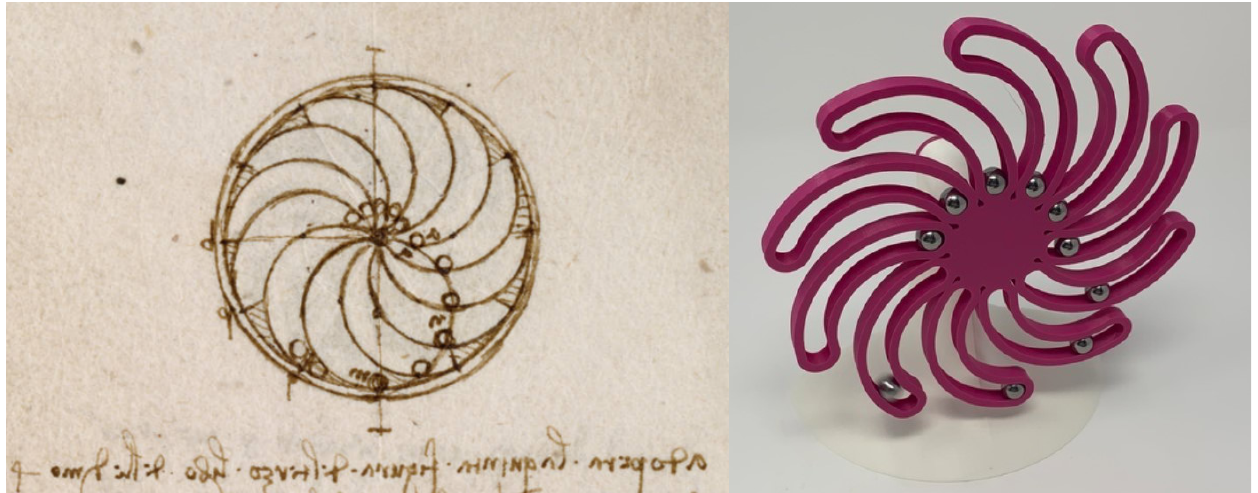
Figure 3: Original perpetual motion sketch (da Vinci, c1600) on left and the automated 3-D printed sculpture called the